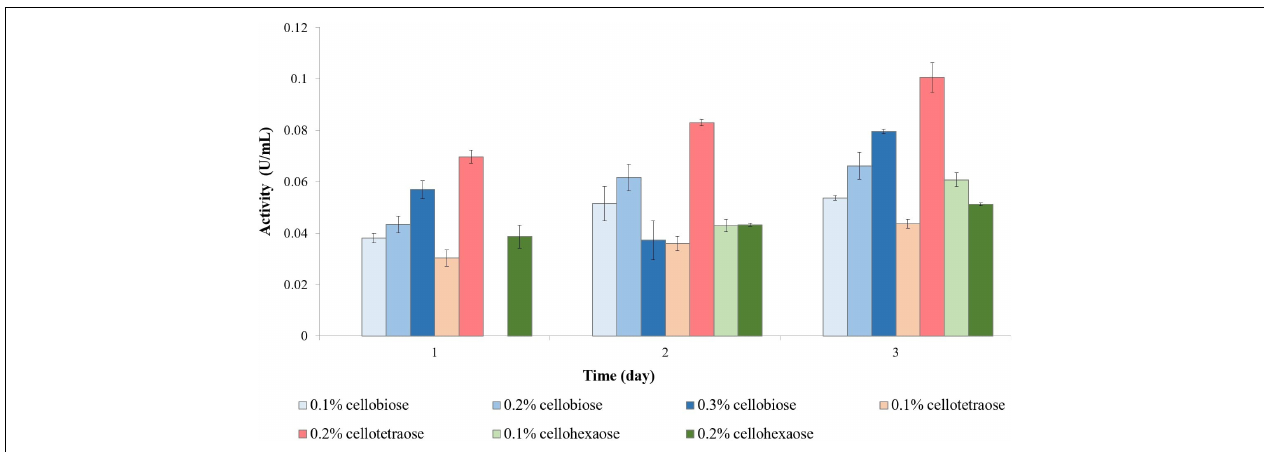
FIGURE 1 | Endoglucanase activity of sucrose-grown biomass in the presence of different inducers and using CMC as substrate. No activity was detected in the presence of other inducers or the control sample.